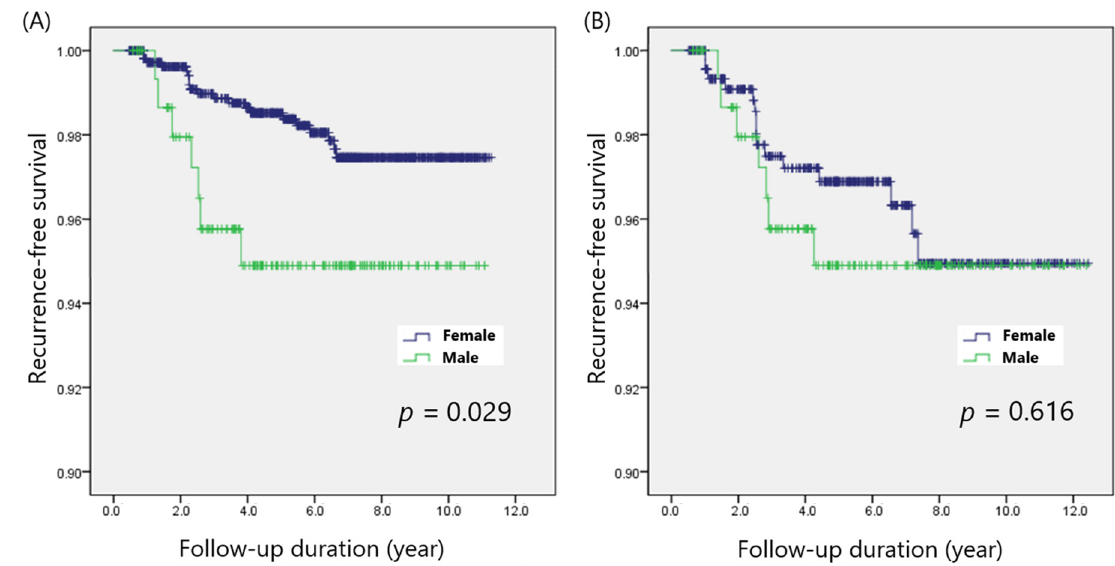
Figure 1. Disease-free survival according to sex, ( A ) before and ( B ) after propensity score matching.